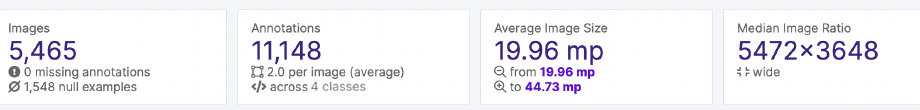
Figure 10. Dataset Health Check.